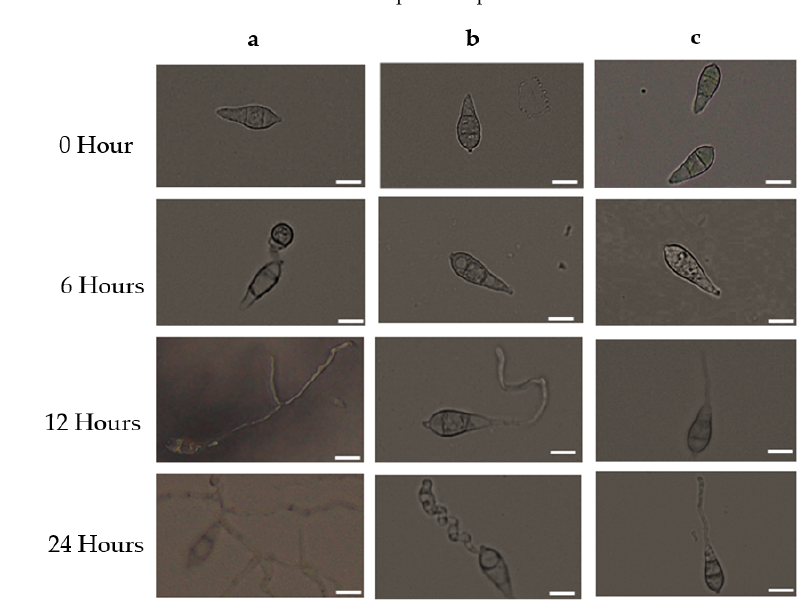
Figure 5. The time-dependent alterations in MoT germination of conidia and subsequent morpho- logical changes in the presence of antimycin A and the commercial fungicide Nativo ® 75 WG. Dose of antimycin A was 10 µg/mL. ( a ) Control, ( b ) antimycin A, and ( c ) Nativo ® 75 WG. Germinated conidia; short germ tube; elongated germ tube. Bar = 10 µm. Table 1. Effects of antimycin A and the fungicide Nativo ® 75 WG on germination of conidia and morphology of germ tubes and appressoria of Magnaporthe oryzae Triticum at 10 µg/mL in vitro. Treatment